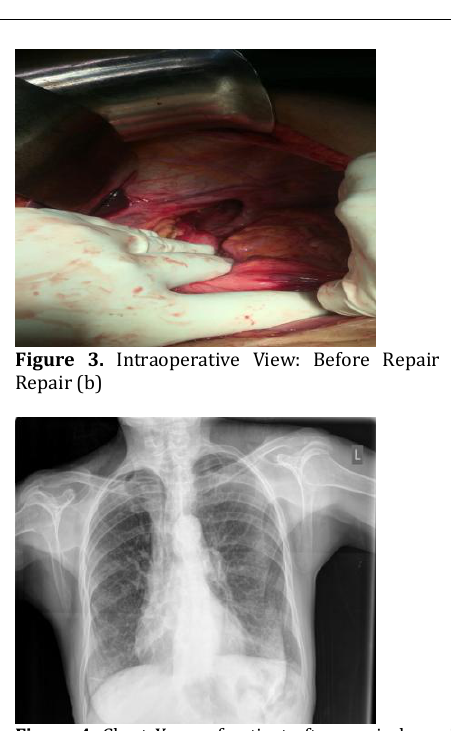
Figure 2. CT-scan of patient before surgery